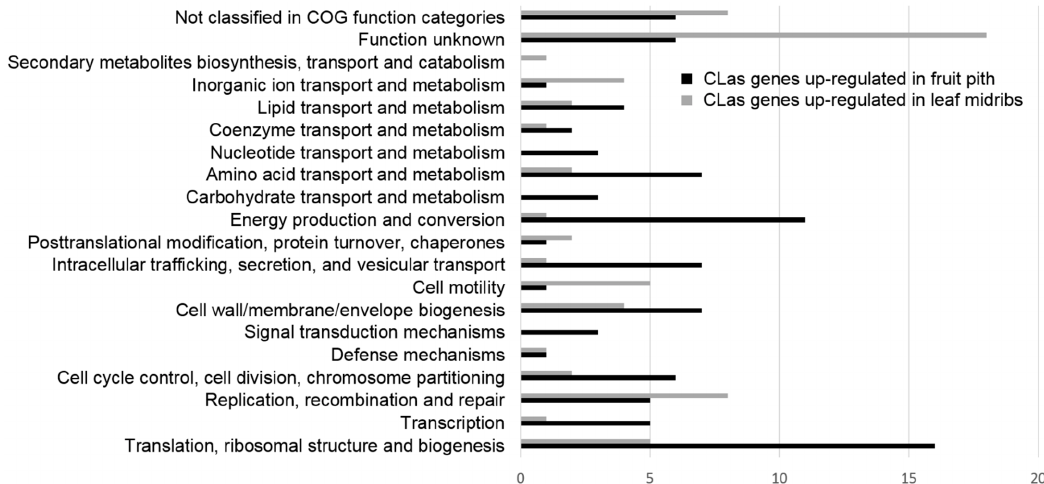
Figure 3. Functional classification of differentially expressed genes (DEGs) of “ Candidatus Liberibacter asiaticus” in leaf midribs tissue and fruit pith tissue. The DEGs were identified with CLC Genomic Workbench v20 by setting Log2 fold change > |1| and FDR < 0.050. Functional annotation and orthologs assignment of all DEGs were performed with eggNOG-mapper v2 by using Clusters of Orthologous Groups (COG) database.